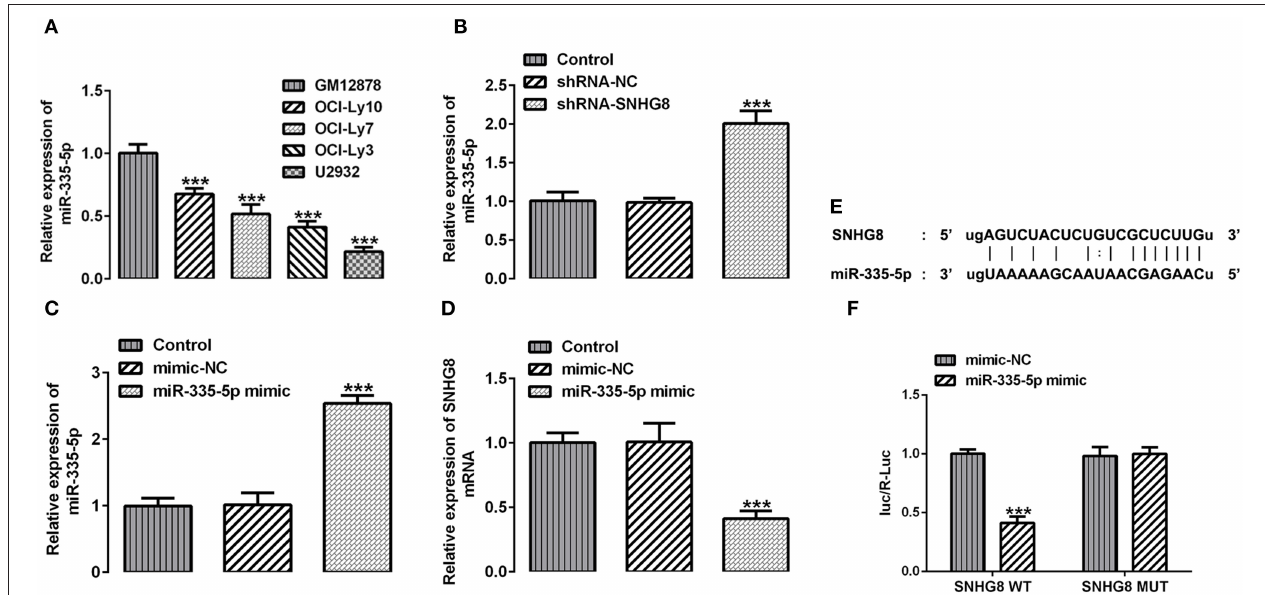
FIGURE 4 | The interaction between SNHG8 and miR-335-5p. (A) The mRNA expression of miR-335-5p in normal human B lymphocytes, GM12878, and human DLBCL cell lines, including OCI-Ly10, OCI-Ly7, OCI-Ly3, and U2932. *** p < 0.001 vs. GM12878. (B) The mRNA expression of miR-335-5p in U2932 cells with or without SNHG8 silence. (C,D) The mRNA expression of miR-335-5p (C) and SNHG8 (D) in U2932 cells transfected with or without the miR-335-5p mimic. *** p < 0.001 vs. shRNA-NC. (E) The binding sites between SNHG8 and miR-335-5p. (F) Wild type (WT) or mutant (MUT) SNHG8 and the miR-335-5p mimic or miR-335-5p mimic-NC were co-transfected into U2932 cells, and then the luciferase reporter assay was performed to validate the direct binding between SNHG8 and miR-335-5p. *** p < 0.001 vs. mimic-NC.